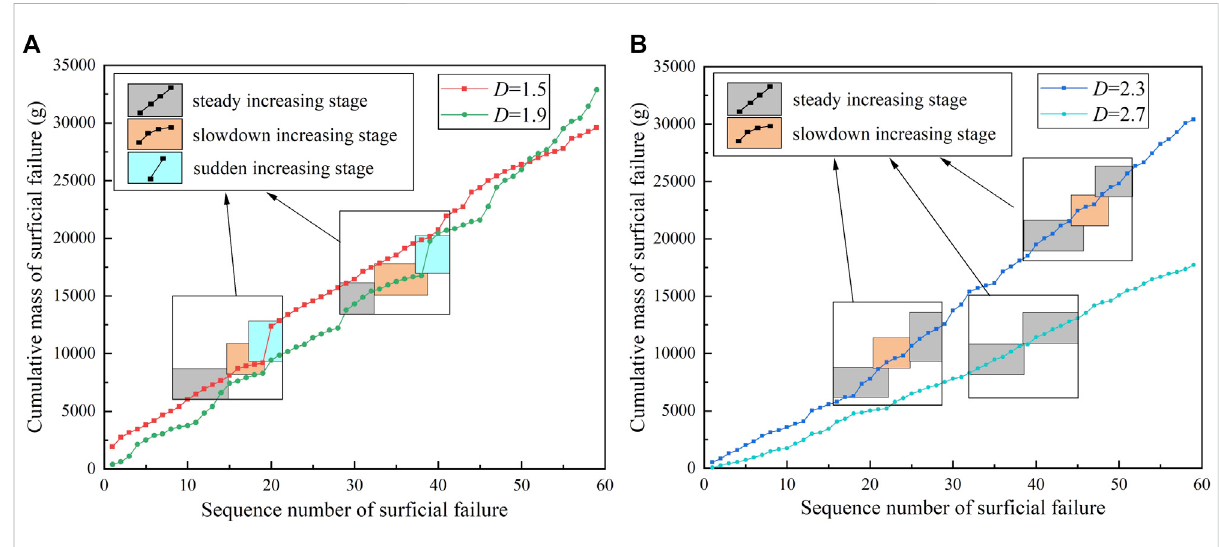
FIGURE 12 Cumulative curve of the mass of sur fi cial failure (A) D = 1.5 and 1.9; (B) D =2.3 and